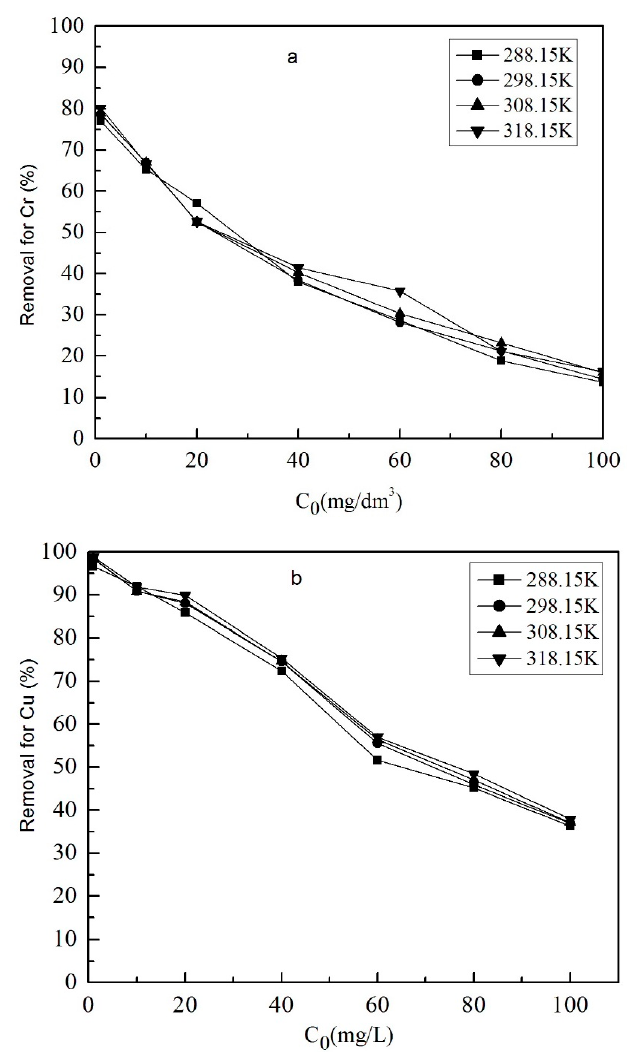
ff ect of temperature on Cr ( a ) and Cu ( b ) removal in mixed Figure 7. Effect of temperature on Cr ( a ) and Cu ( b ) removal in mixed solution. Figure 7. E